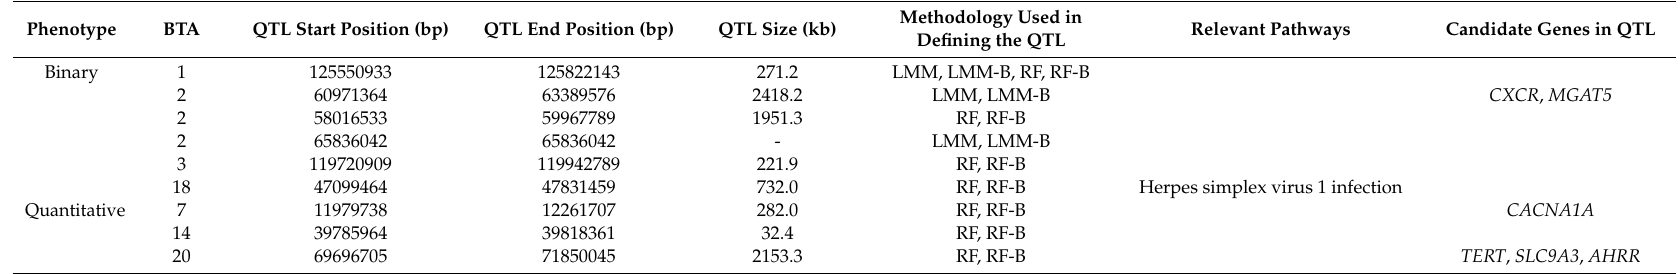
Table 6. Quantitative trait loci (QTL) defined by SNPs that were significant in at least two analyses: linear mixed model (LMM), random forest (RF), or Bayesian regression of top SNPs from linear mixed model (LMM-B) or random forest (RF-B) containing functionally relevant pathways or